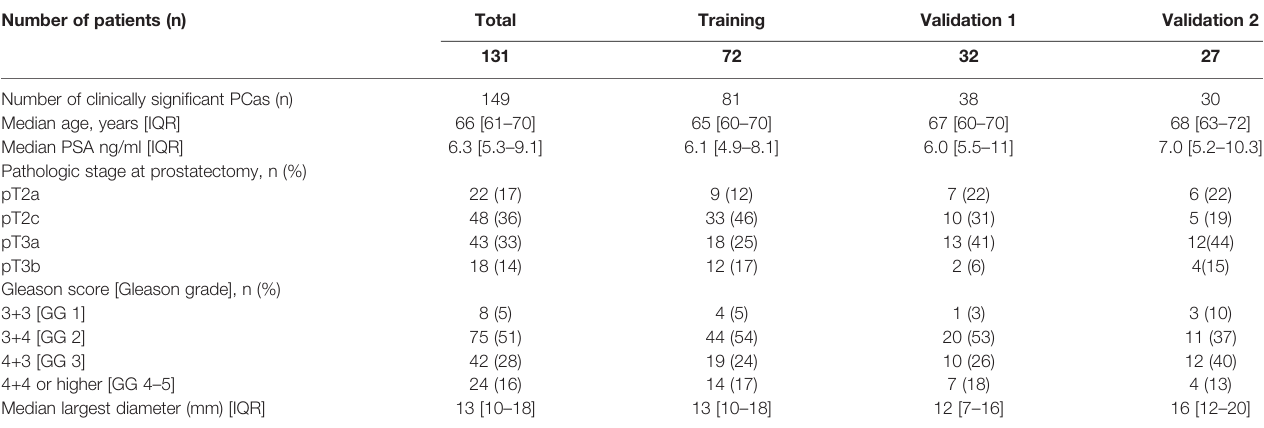
TABLE 1 | Clinical and demographic characteristics of the patient